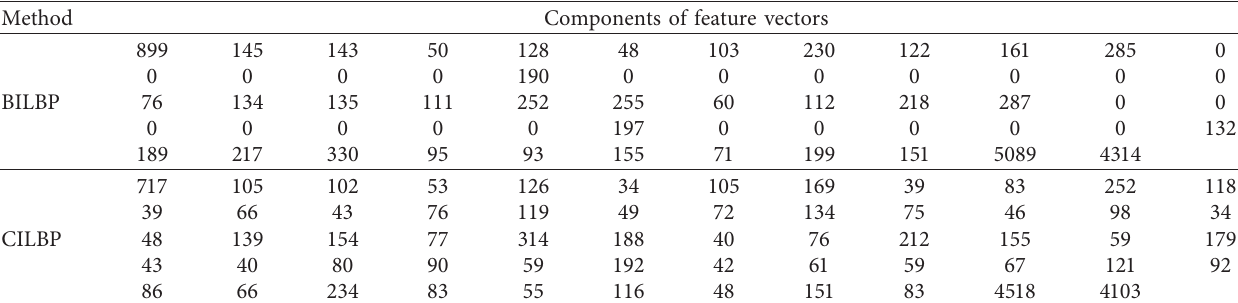
Figure 6: Leaf image encoded with CILBP (block numbers from 1 to 4, from left to right). Table 1: Comparison of eigenvectors of BILBP and